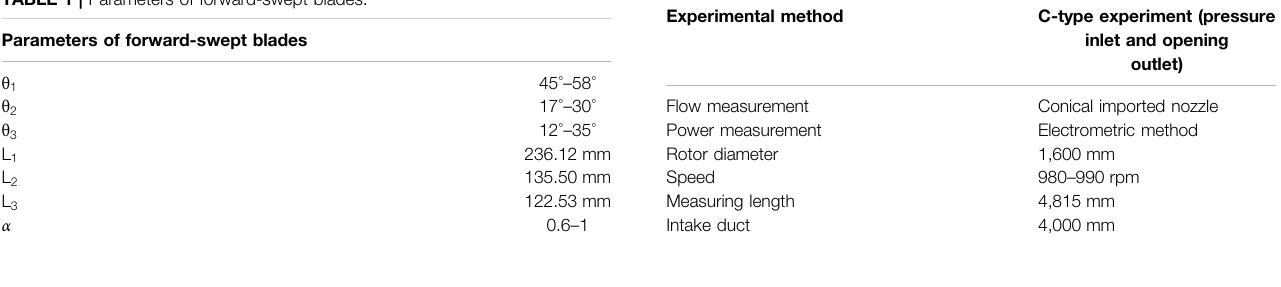
TABLE 1 | Parameters of forward-swept blades.